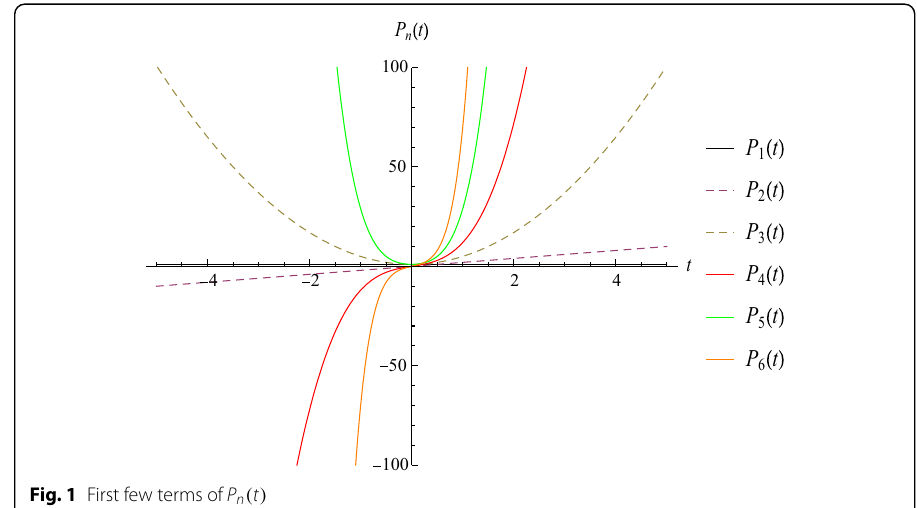
Fig. 1 First few terms of P n ( t